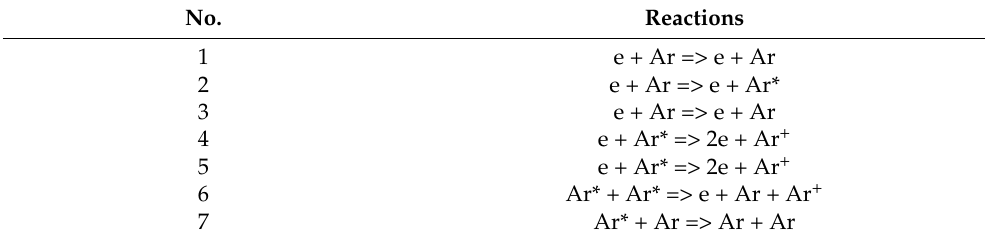
Table 2. Main reactions considered in porous anodic alumina CPED. No.